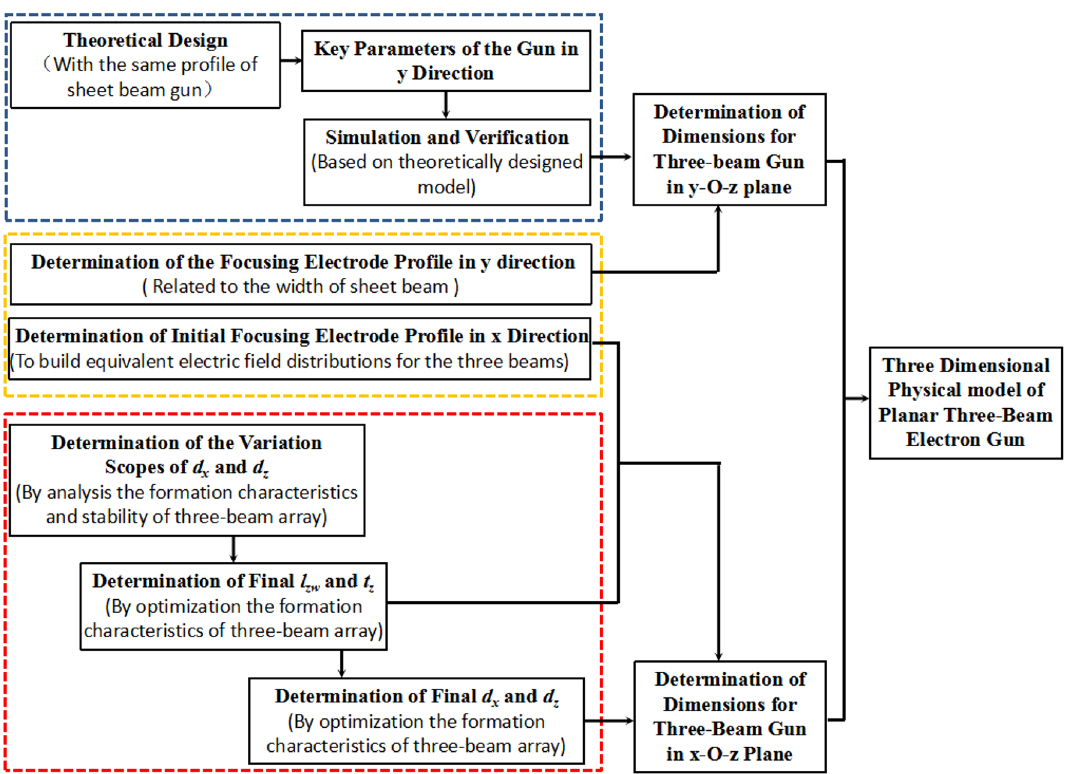
Figure 3. Logical diagram of the design guidelines for the novel planar three-beam electron